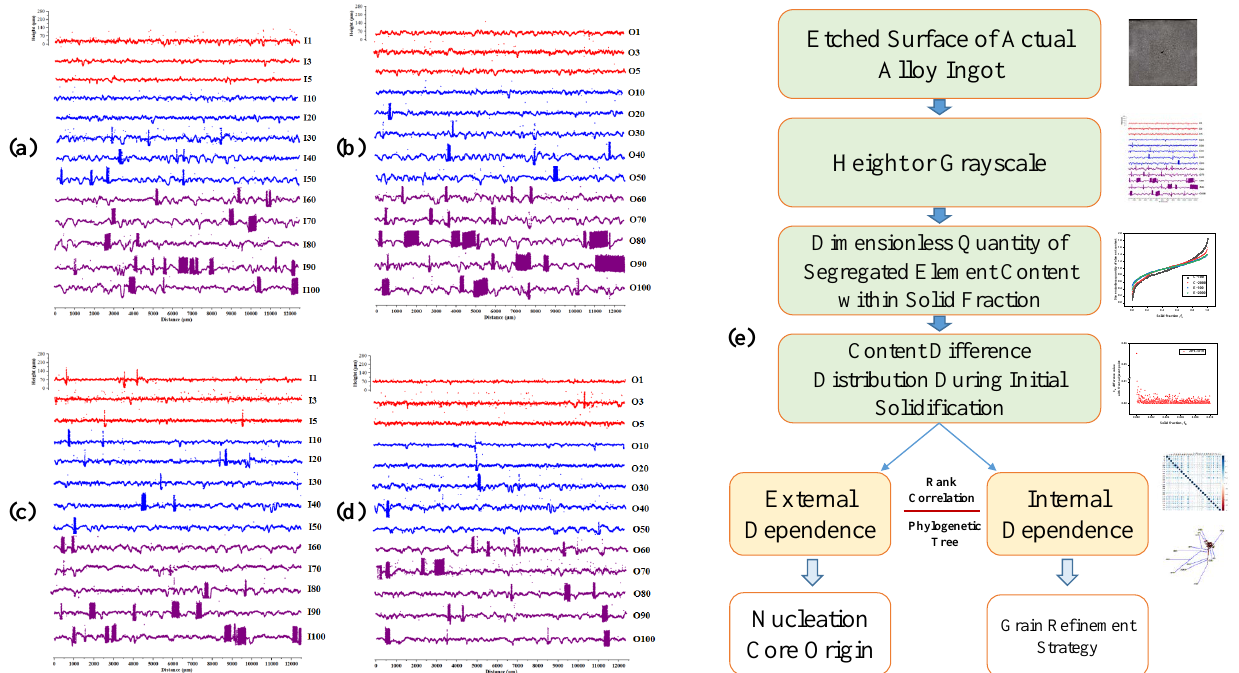
Figure 4. Etched surface heights at different locations of CC billets and brief flowchart of the method. ( a ) Inner curve side under 20 ◦ C, ( b ) outer curve side under 20 ◦ C, ( c ) inner curve side under 35 ◦ C, and ( d ) outer curve side under 35 ◦ C. Every location contains 50,001 height points with the interval of 0.25 µ m. The red, blue, and purple distribution lines denote the heights in the chilled zone, columnar grain zone, and equiaxed grain zone, respectively. The scanning length of each location is 12.5 mm. The capital letter I or O in the location label denotes the inner curve side or the outer curve side, and the number that follows denotes the distance from the location to corresponding billet edge. ( e ) Brief flowchart for determining nucleation core origin and grain refinement strategy for the actual large alloy ingot (whether to use the etched surface height or grayscale depends on their effectiveness for element content distribution during initial